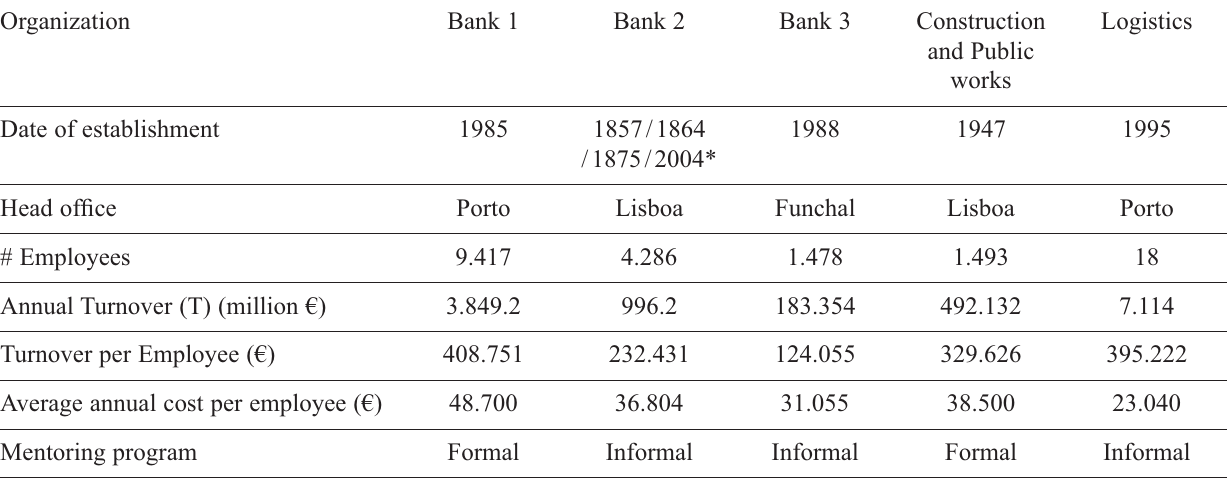
Table 1. The organizations in fi gures (2005)